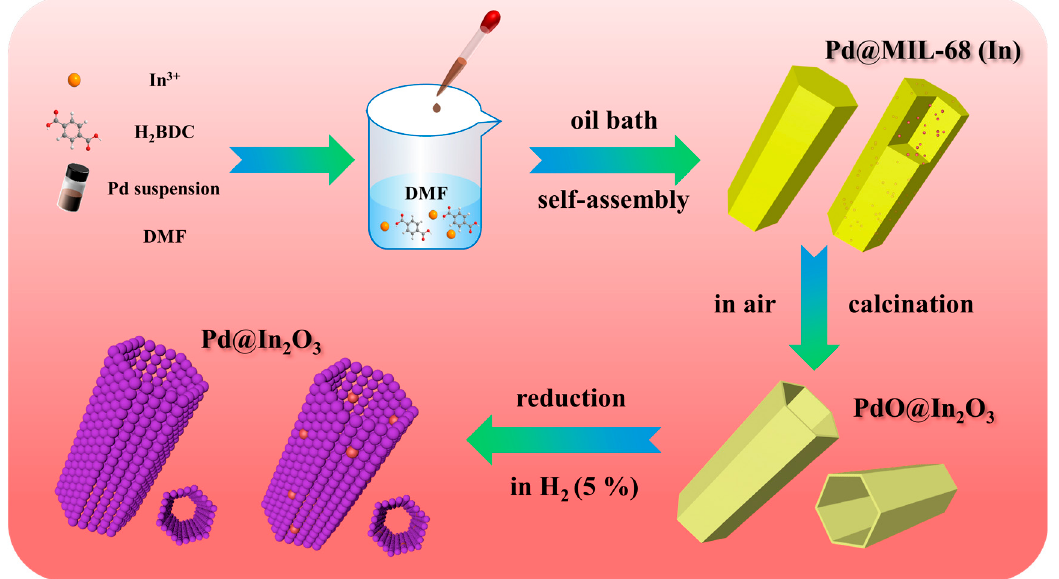
Figure 1. Schematic illustration of the preparation process of Pd@In 2 O 3 PHTs.